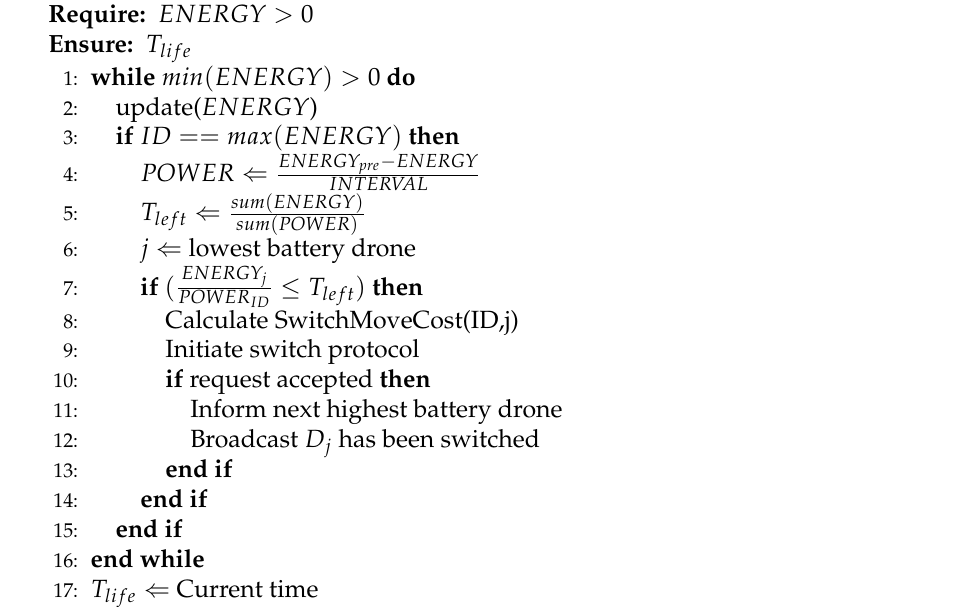
Algorithm 5: Positions Dynamic Switch: Calculate T life